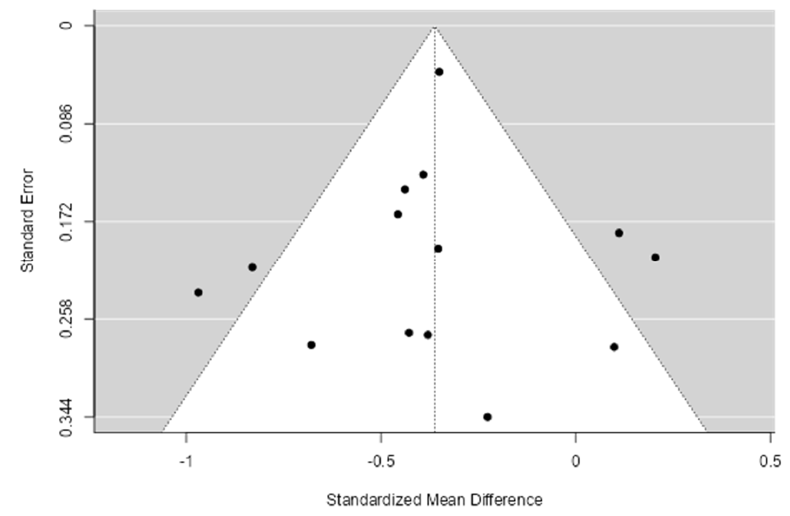
Figure 3. Funnel plot after removing outlier